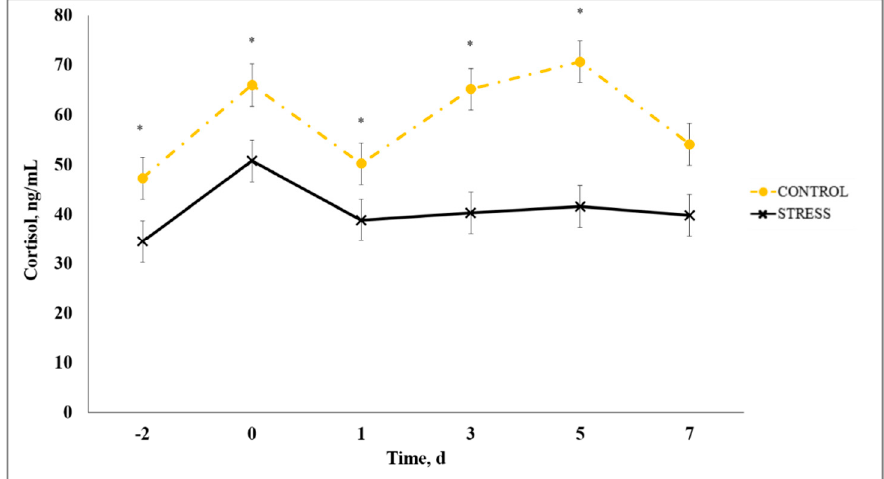
Figure 4. Effect of non-stress control (C; weaned on Day − 37; transported to West Texas A&M University research facility on Day − 21; vaccination on Day 0) and stress model implementation (S: weaned on Day − 3; transported to USDA-ARS Livestock Issues Research Unit on Day − 2; relocated to WTAMU on Day − 1; vaccination on Day 0) on serum cortisol concentration. Serum cortisol concentration C vs. S (stress model × day interaction; p < 0.01). * C differs from S within day, p ≤ 0.05.